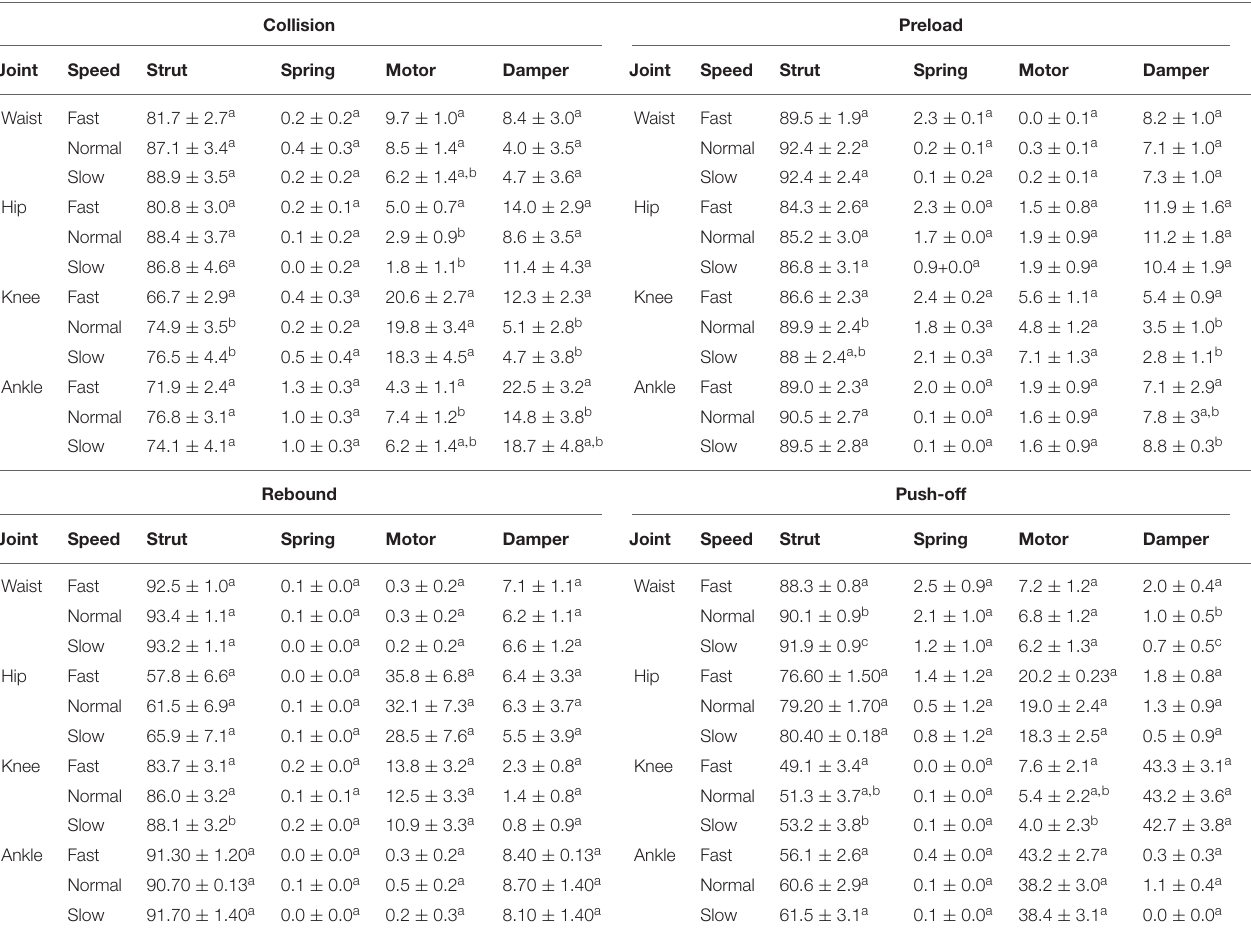
TABLE 3 | The functional indices of joints during different phases across three walking